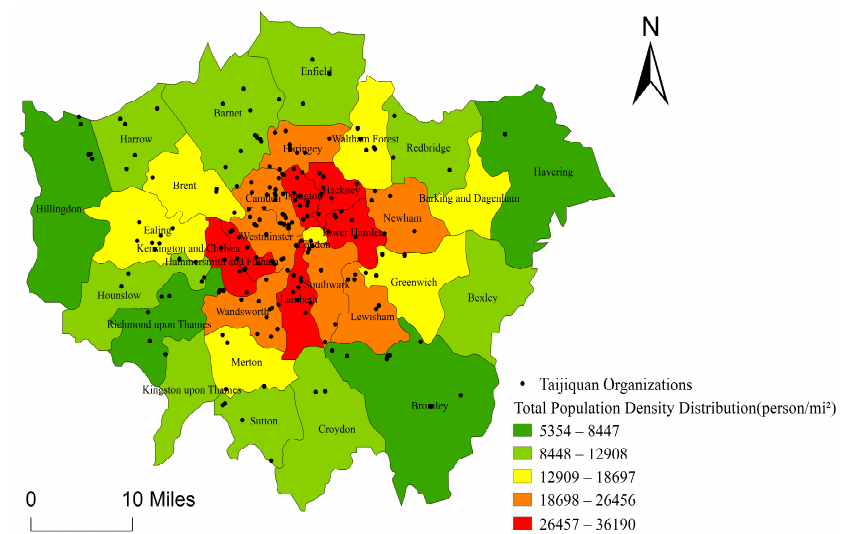
Figure 7. Population Density Map of Boroughs in London.